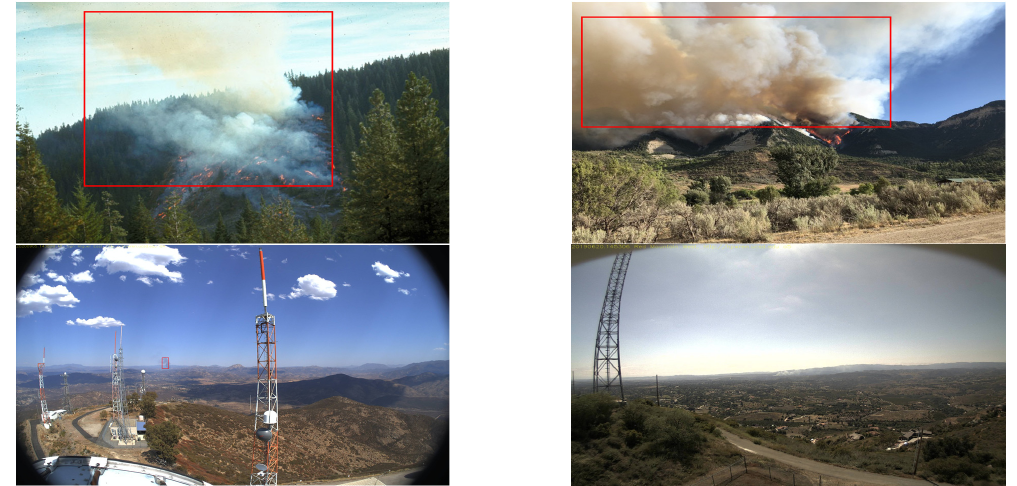
Figure 10. Detection results using deformable DETR.